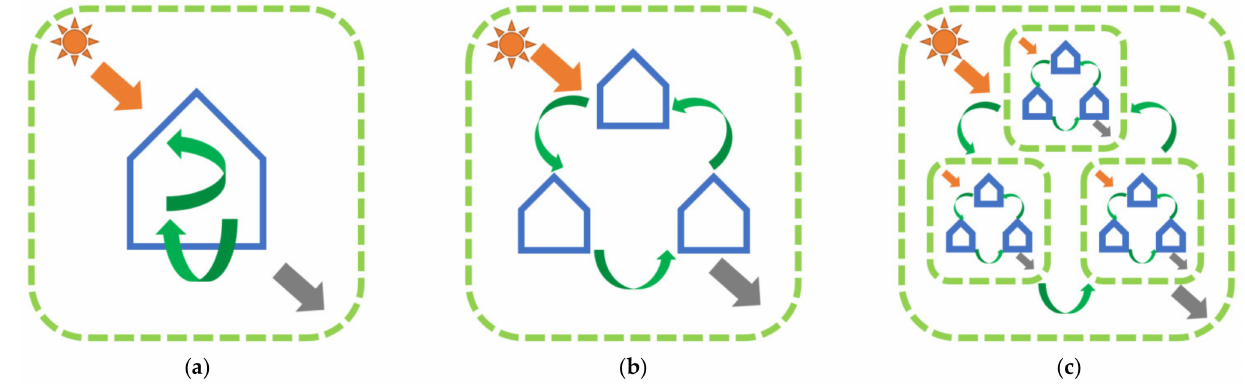
Figure 2. Schematic diagram of the hierarchical division of the rural human settlement unit. ( a ) Court- yard unit; ( b ) Cluster unit; and ( c ) Village